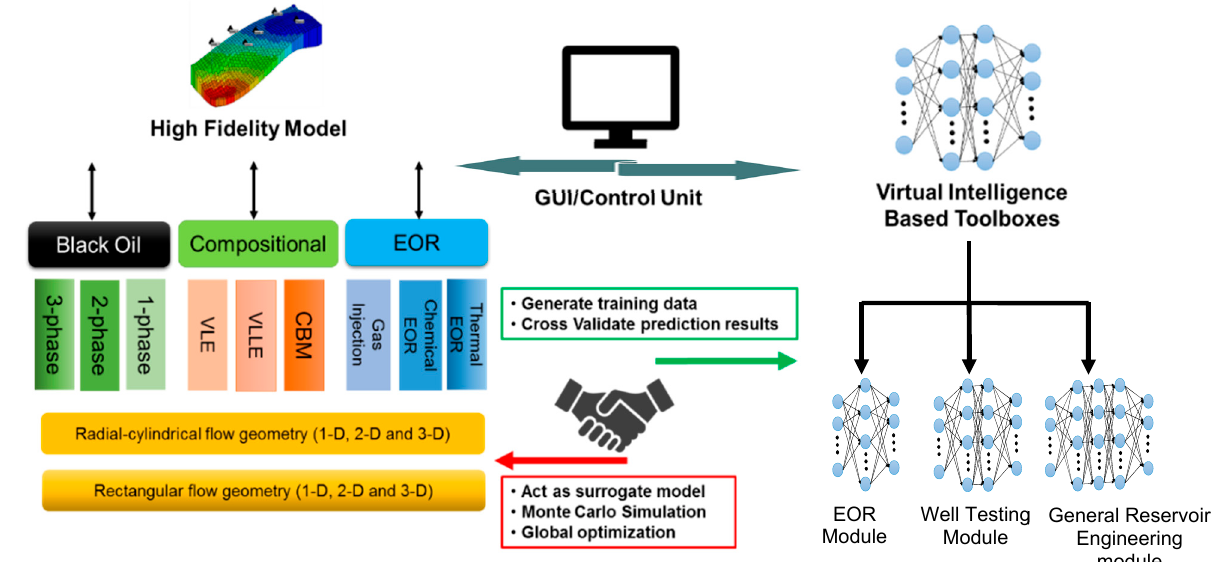
Figure 3. The overall architecture of a computational platform on which the computational interactions of deterministic and proxy models are accomplished (Notes: VLE—vapor/liquid equilibria; VLLE—vapor/liquid/liquid equilibria; CBM— coalbed methane; EOR—enhanced oil recovery).